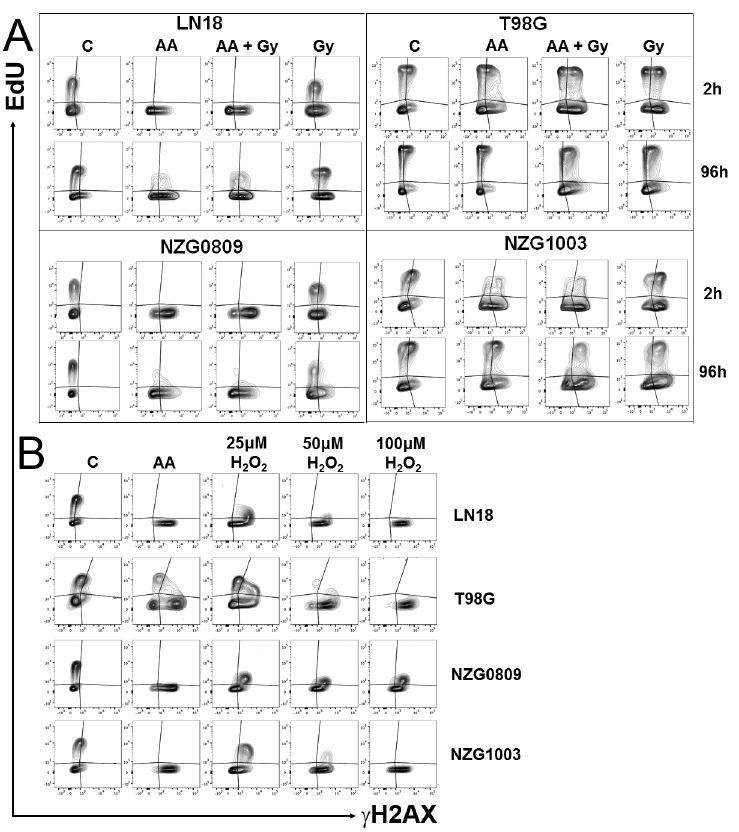
Figure 4. DNA synthesis indicated by EdU incorporation ( y -axis) versus DNA damage by γ H2AX foci ( x -axis). Cells were treated as indicated and harvested after 2 h (A and B) or 96 h ( A ). ( B ) Effect of a 1 h exposure to 5 mM AA compared with that of different concentrations of H 2 O 2 . Flow cytometry plots are representative of at least three independent experiments.